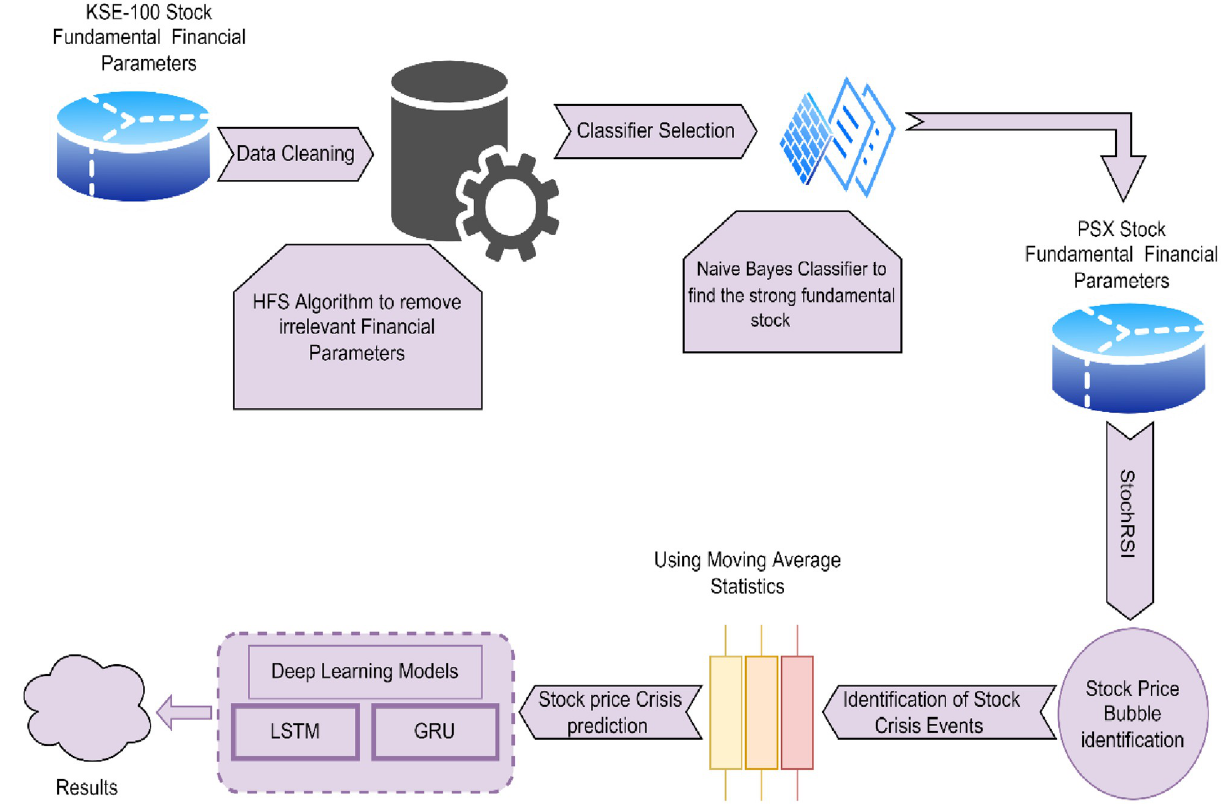
Fig 1. Proposed model for stock price crisis